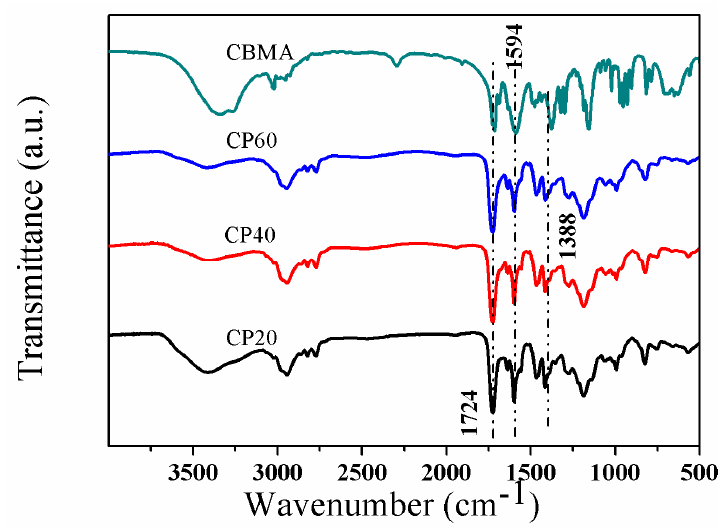
Figure 3. FTIR spectra of CBMA, CP20, CP40, and CP60.